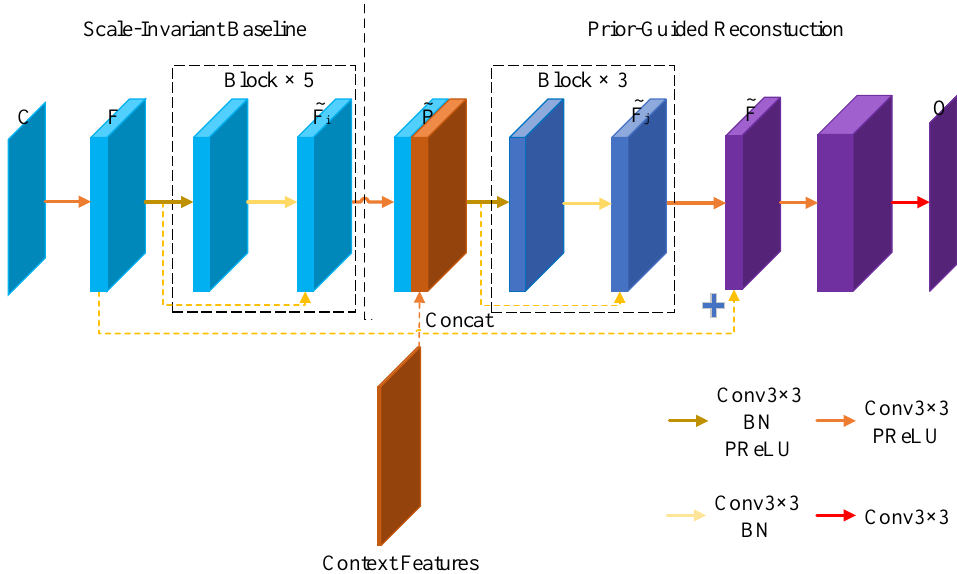
Figure 2. The framework of the proposed CARNet. Each component of our network is designed to complete a specific